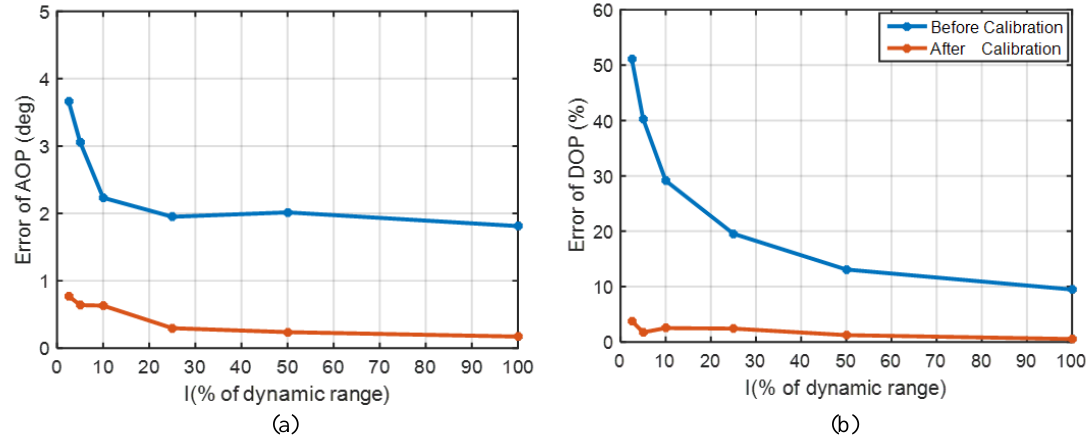
Figure 7. ( a ) the error of AOP as light intensity varies; ( b ) the error of DOP as light intensity varies.